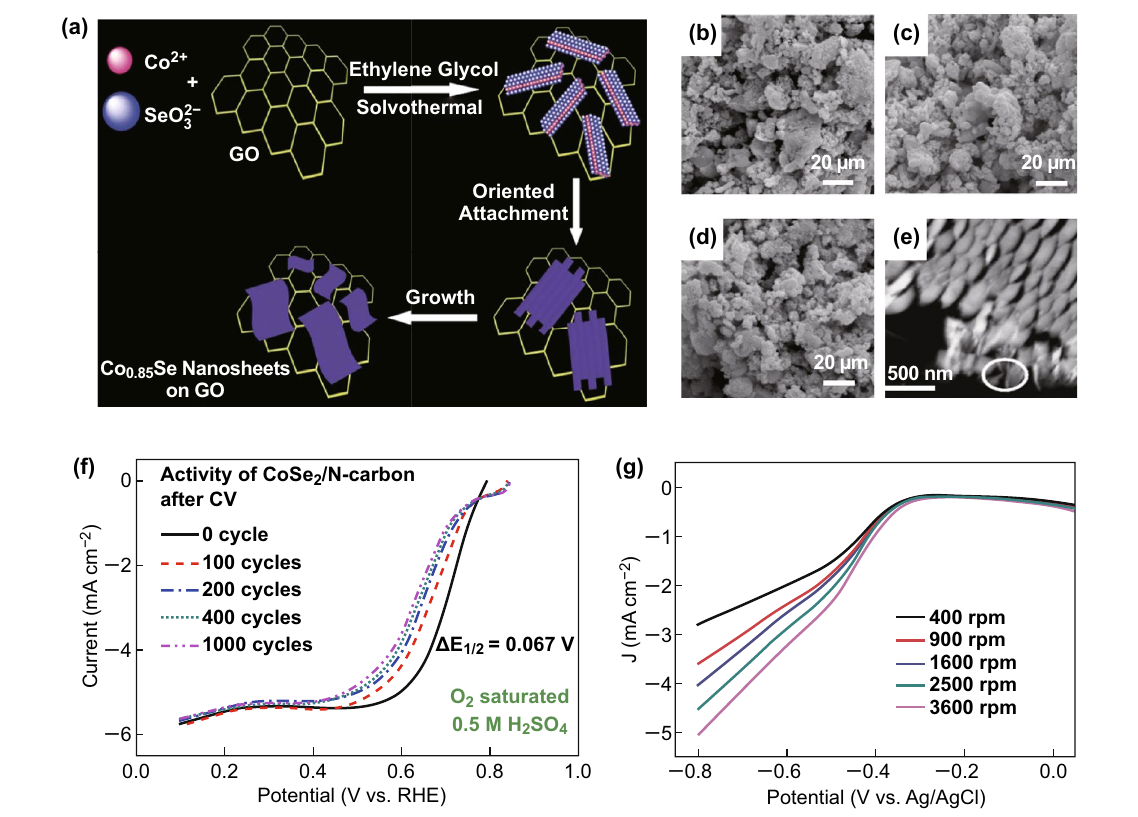
Fig. 11 a Schematic diagram of the synthesis of ultrathin Co 0.85 Se/graphene nanocomposites. SEM micrograph of synthesized Co–Se catalyst powder, b 31.7 mol% Se, c 67.1 mol% Se. d 70.9 mol% Se. e In progressively enlarged magnified image, the slice sample of the component Co (44%) Se (56%). f Stabilities of CoSe 2 /N–carbon catalysts. The activity decay after 1000 CV cycles, DE 1/2 , is marked on the graph. g RDE curve of Co 0.85 Se/graphene (loaded approximately 0.1 mg cm −2 ) in O 2− -saturated 0.1 M KOH was 10 mV s −1 at different speeds. Adapted from